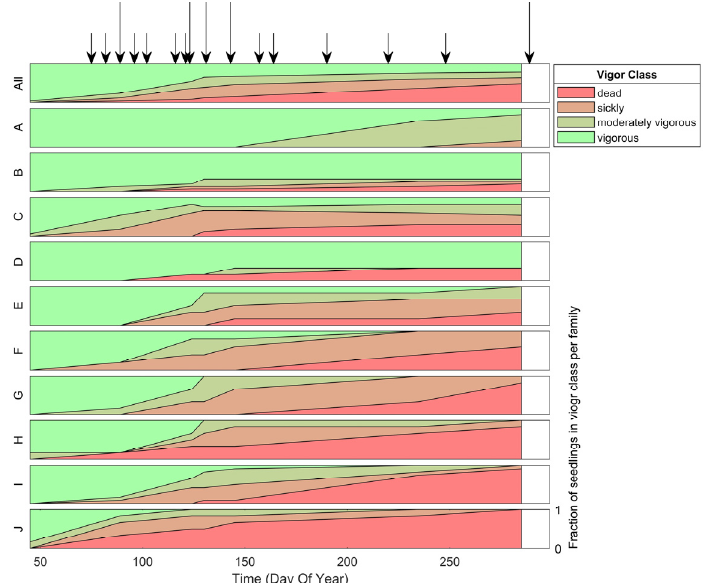
Figure 1. Fraction of seedlings ( y -axis) in each vigor class based on visual assessments of inoculated seedlings over time ( x -axis) for all infected seedlings (top panel) and per family (A-J panels). Note the differences per family in terms of the fraction of seedlings within each vigor class and the timing of vigor reduction. Arrows indicate the hyperspectral image acquisition dates. The longer arrows indicate the image acquisition dates that were closest to a visual assessment and were therefore used for vigor classification. Hyperspectral imaging (HSI) was more frequent during the onset of the disease. Once the change in symptom expression slowed down the frequency of HSI was reduced as well.